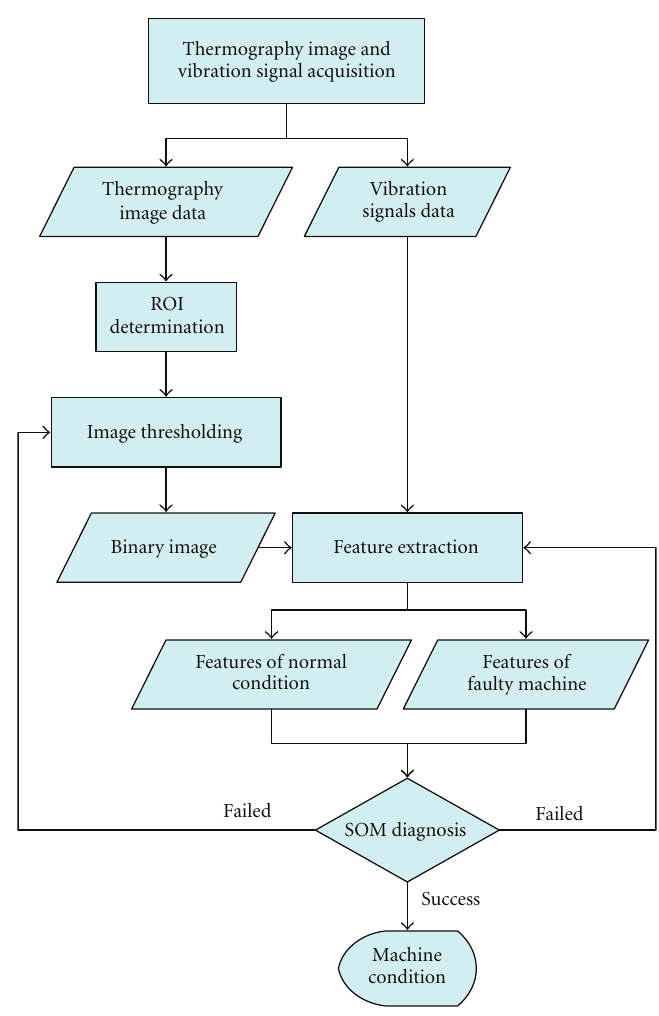
Figure 2: Flow chart of SOM diagnostics process.